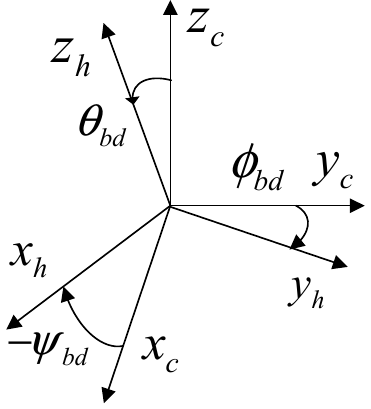
Figure 3. Identical poses looking different according to the camera view angles. ( a ) from top to bottom, ( b ) rotated 90 degrees clockwise, ( c ) from the front left.